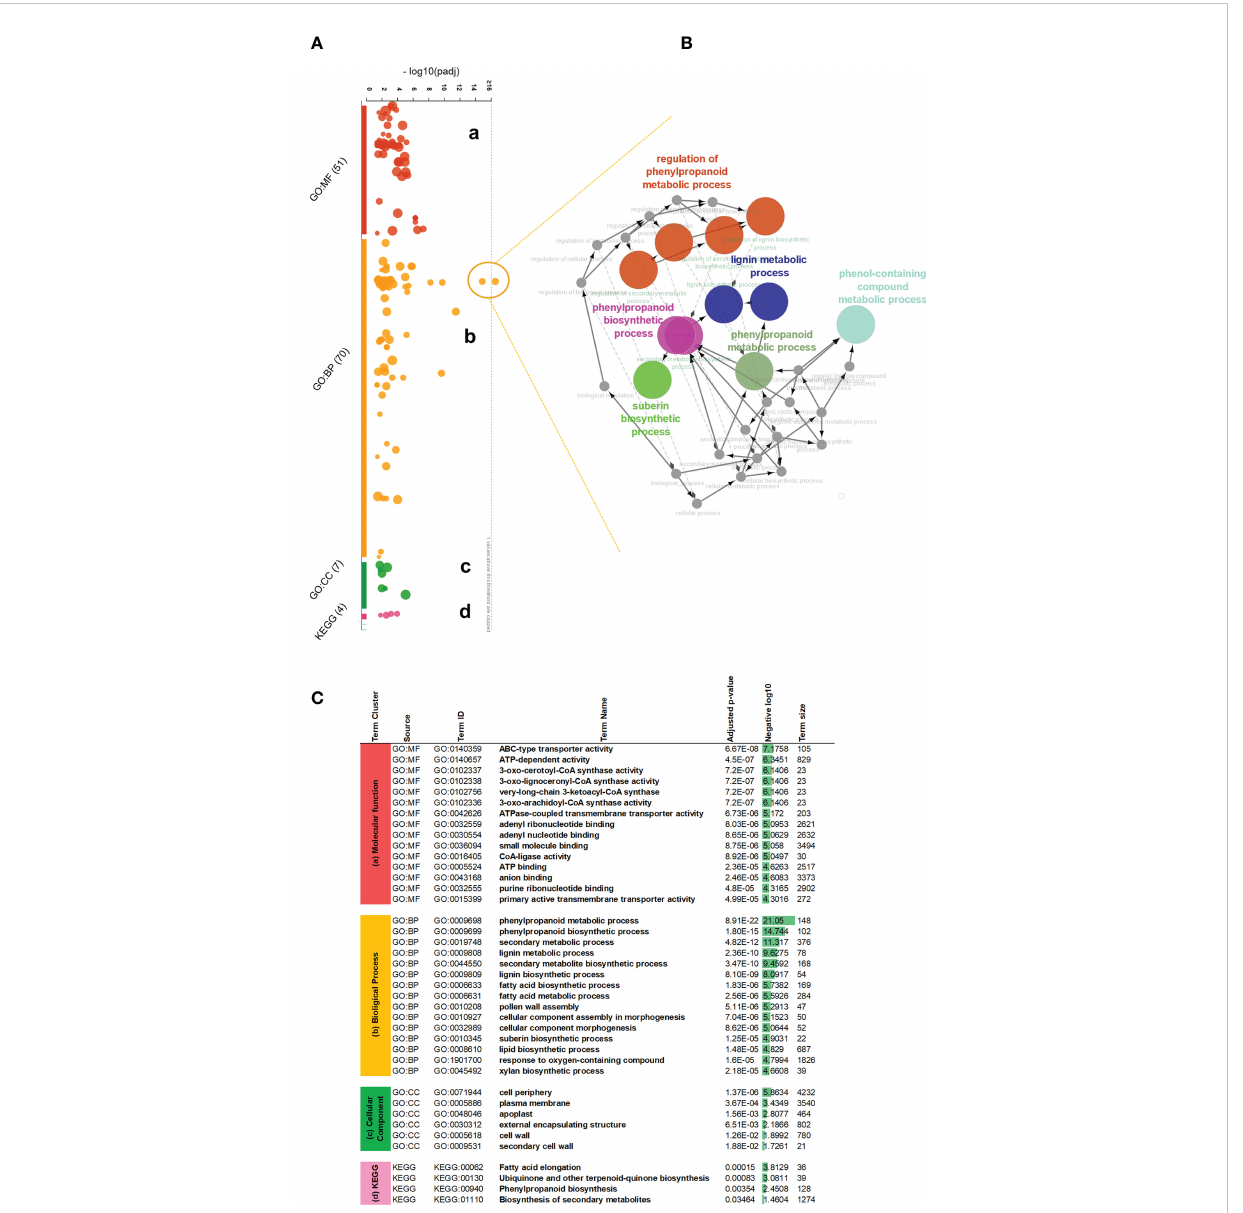
FIGURE 2 Gene ontology enrichment analysis of the differentially expressed genes obtained 4 days after agroin fi ltration with empty vector and MdMYB68 constructs in N. benthamiana . (A) An interactive Manhattan plot visualizes enriched GO term cluster within plant response to MYB68 overexpression. The x-axis shows the functional terms from 2840 upregulated genes. The circle on the plot represents a single functional term. Each circle is color- coded and grouped into the functional terms according to the annotated genes in each term. Four main gene ontology groups are identi fi ed: (a) molecular biology, (b) biological process, (c) cellular compartment, (d) KEGG Kyoto Encyclopedia of Genes and Genomes annotation. The corresponding enrichment p-values in negative log 10 scale are illustrated on the y-axis. The hypergeometric p-value is calculated with the g:Pro fi ler software and represent the signi fi cance of functional term in the input gene list. (B) Expanded view and network mapping of the genes corresponding to GO:0009698 and GO:0009699 terms, indicating the highest p-value. The nodes are the functional groups and edges are interaction. The gene network was plotted by applying the cytoscape ClueGO v2.5, CluePedia v1.5 plugins and highlights interaction of most regulated biological processes revealed signi fi cant stimulating in the phenylpropanoid fatty acid pathway. (C) Table of most signi fi cant gene ontology terms enriched after MYB68 overexpression. Based on the p-value, top 15 gene terms from the cluster a (MF) molecular function and cluster b (BP) biological process, along with all terms from the cluster c (CC) cell compartments and cluster d (KEGG) were highlighted and presented as most relevant processes to be